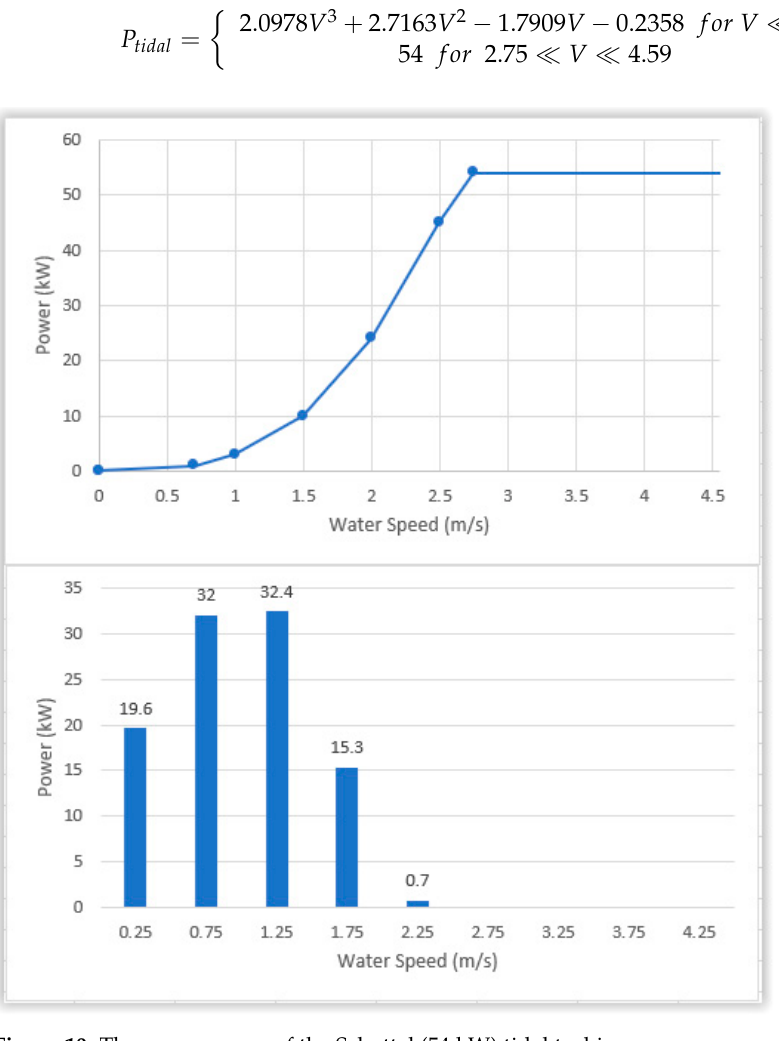
Figure 10. The power curve of the Schottel (54 kW) tidal turbine. Other pertinent details for the Schottel tidal turbine are given in Table 3. Table 3. Tidal turbine details.